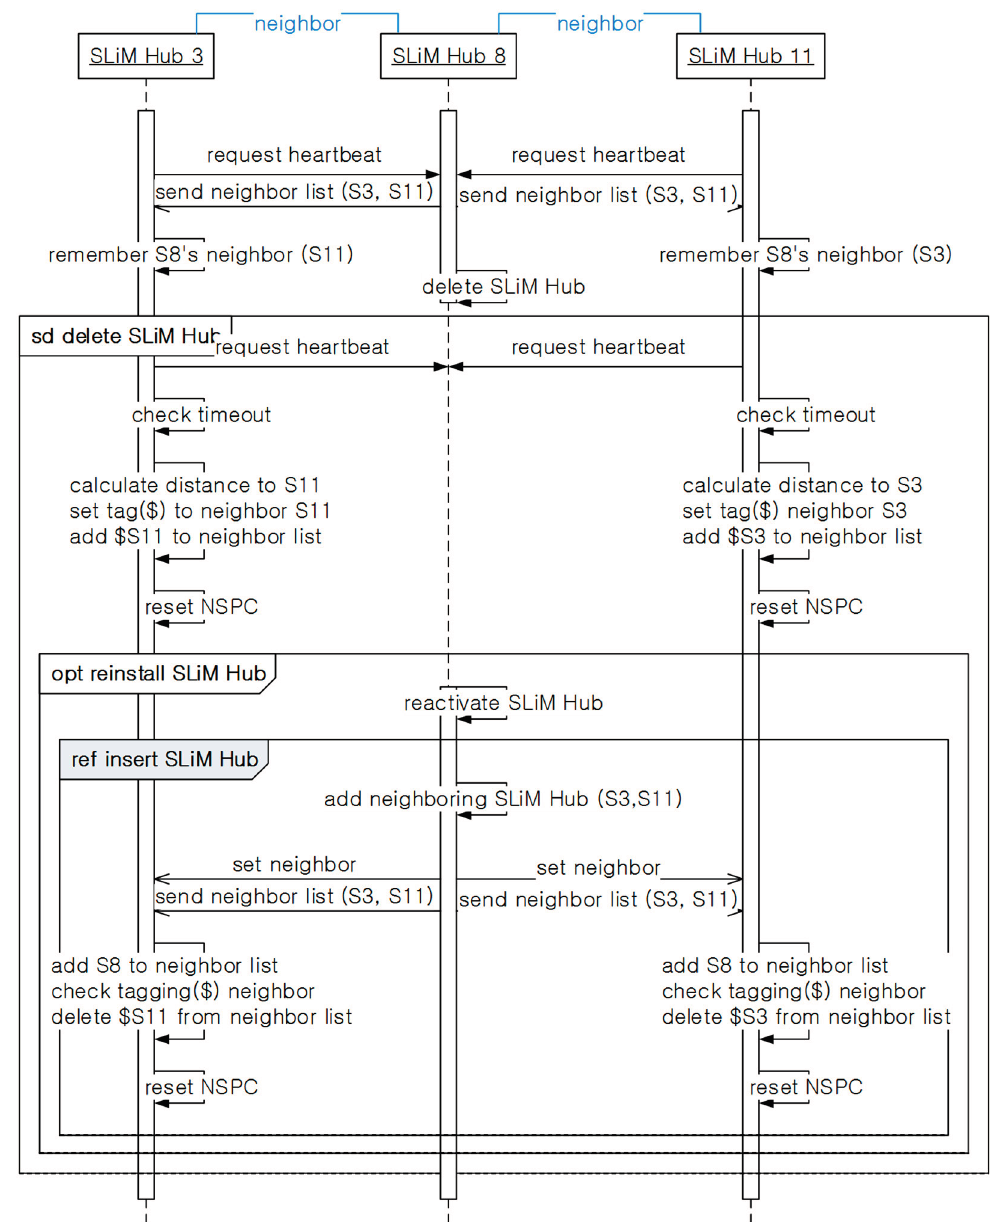
Figure 16. The sequence of installing or reinstalling a SLiM